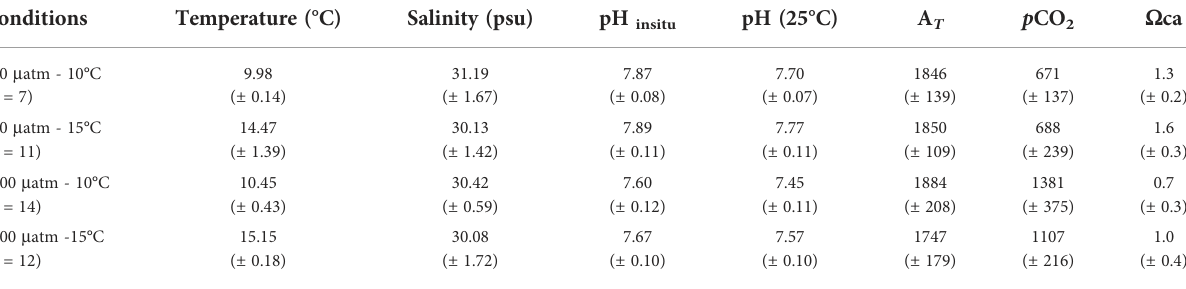
TABLE 1 Average conditions (± SE) of carbonate system parameters for each experimental treatment: p CO 2 (500 and 1500 m atm) and temperature (10 and 15°C).